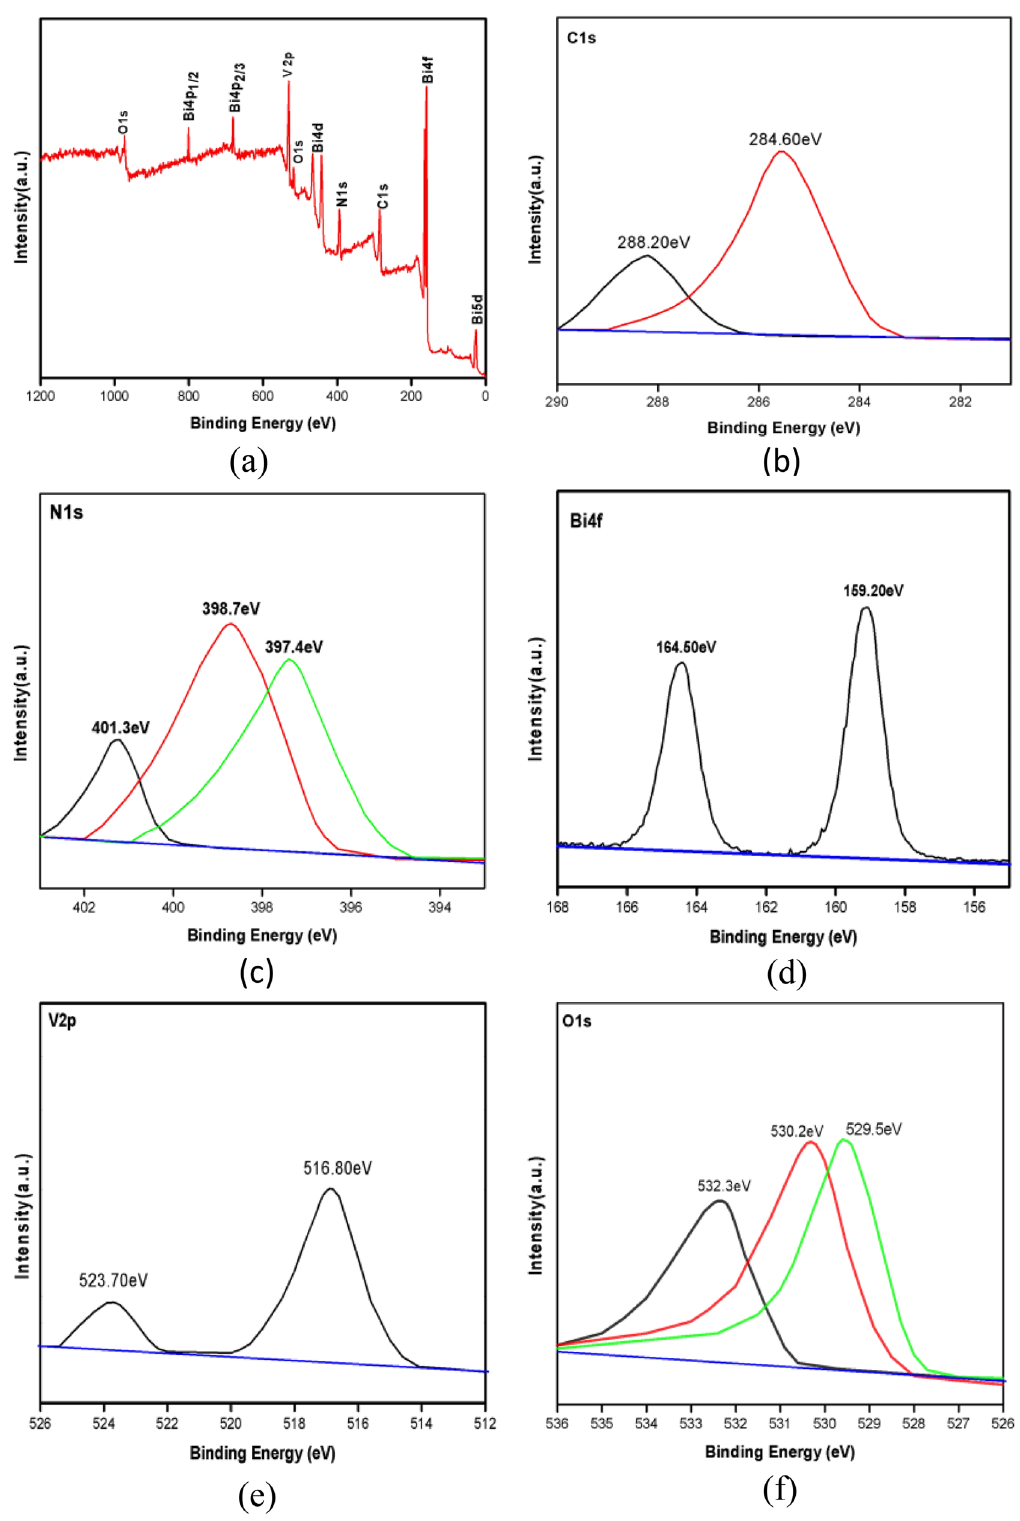
Figure 11: XPS diagram of spectrum analysis of GCBC composite samples: ( a ) full spectrum of all fi ve elements, ( b ) spectrum of C, ( c ) spectrum of N, ( d ) spectrum of Bi, ( e ) spectrum of V, and ( f ) spectrum of